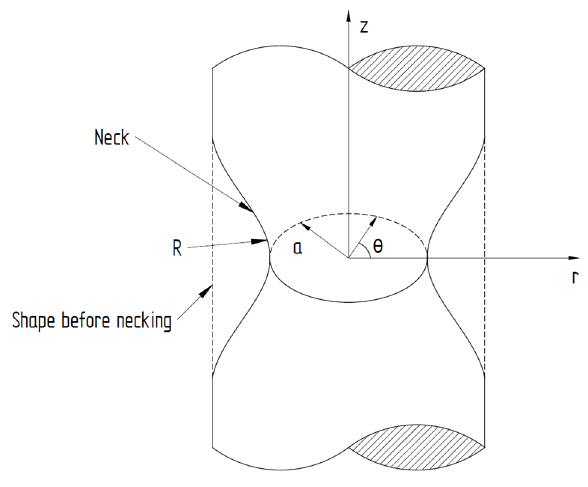
Figure 13. Tensile necking in a cylindrical test piece [43].